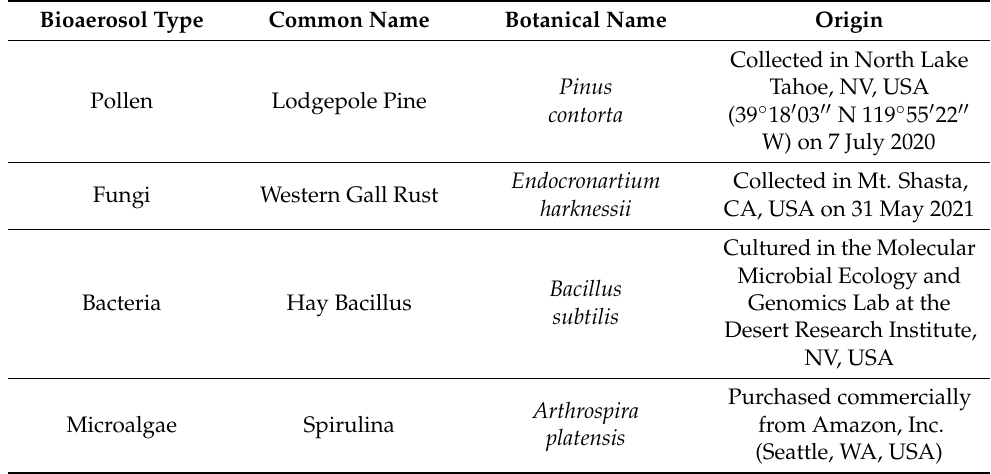
Table 1. Bioaerosols used for sample preparation of starch content